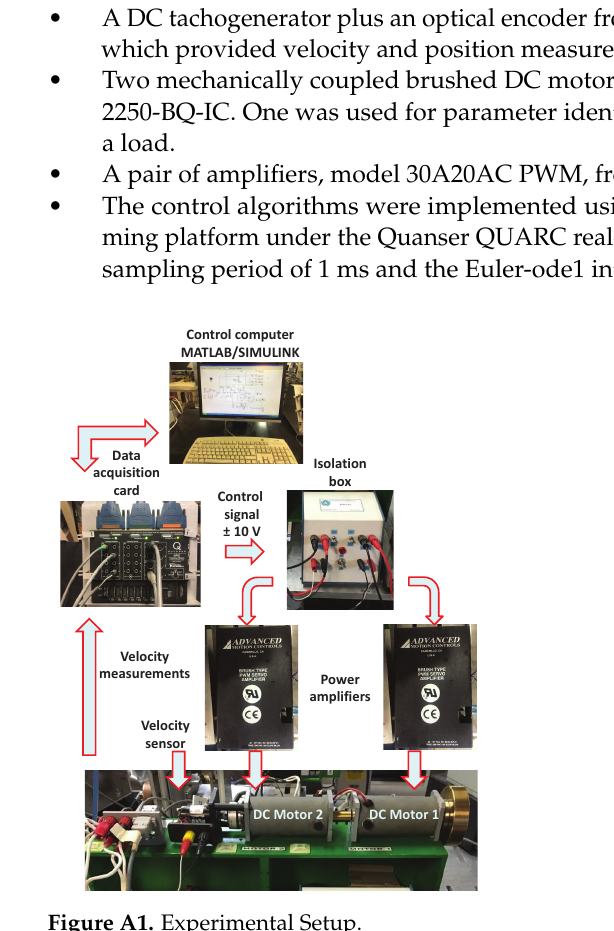
Figure A1. Experimental